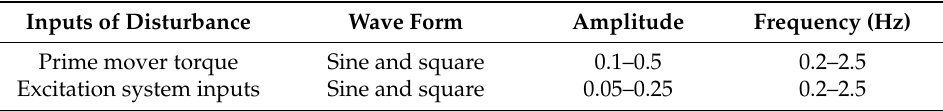
Table 4. Disturbances of forced